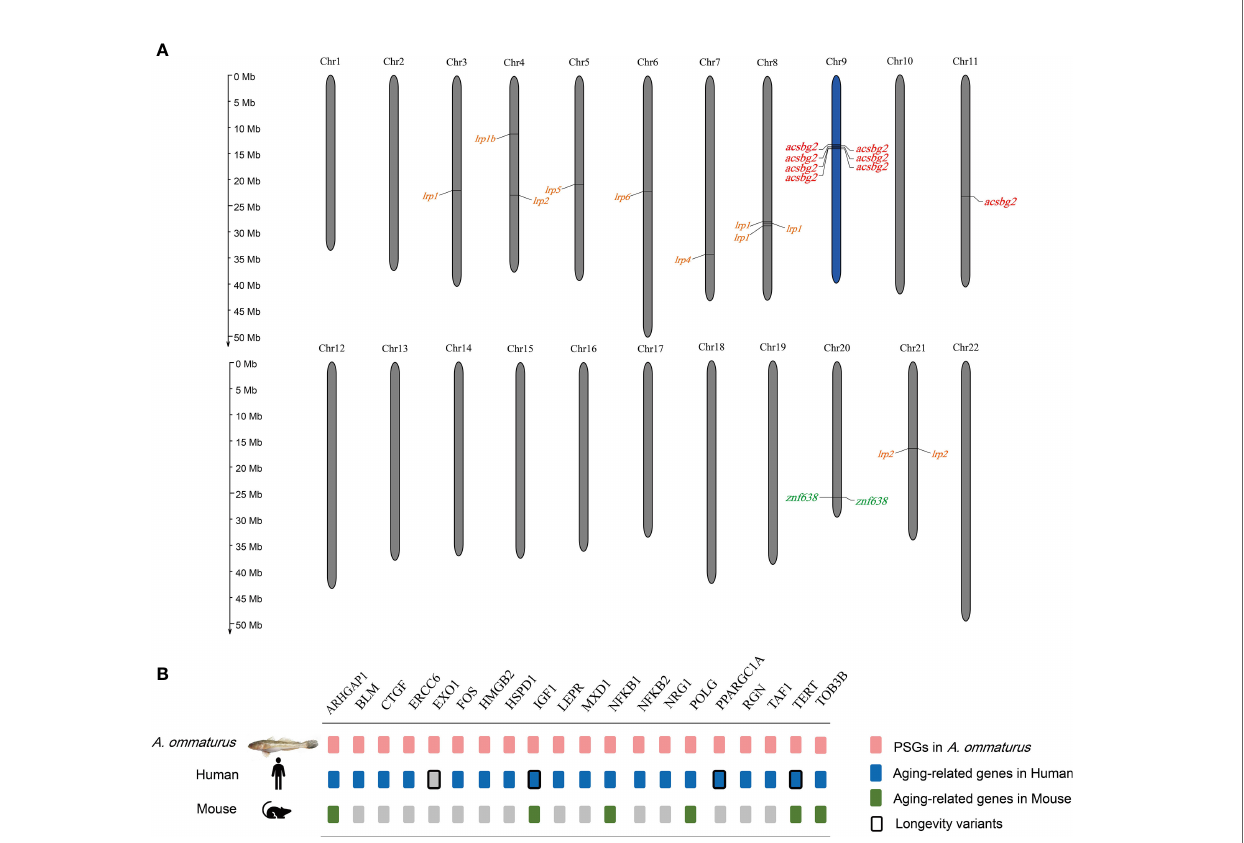
FIGURE 3 | (A) The location of expanded genes related to lipid metabolism in A. ommaturus chromosomes. (B) Candidate aging-related genes under positive selection in A. ommaturus